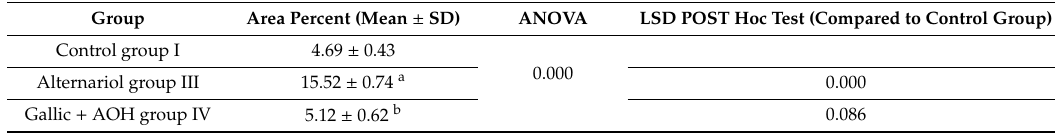
Table 1. The area percent of anti-4-HNE immune stained sections in di ff erent groups.